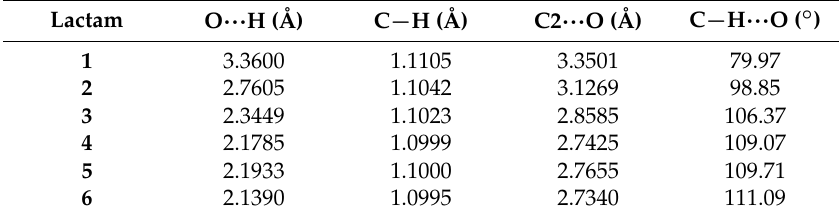
Table 2. Geometrical parameters of closed structures.